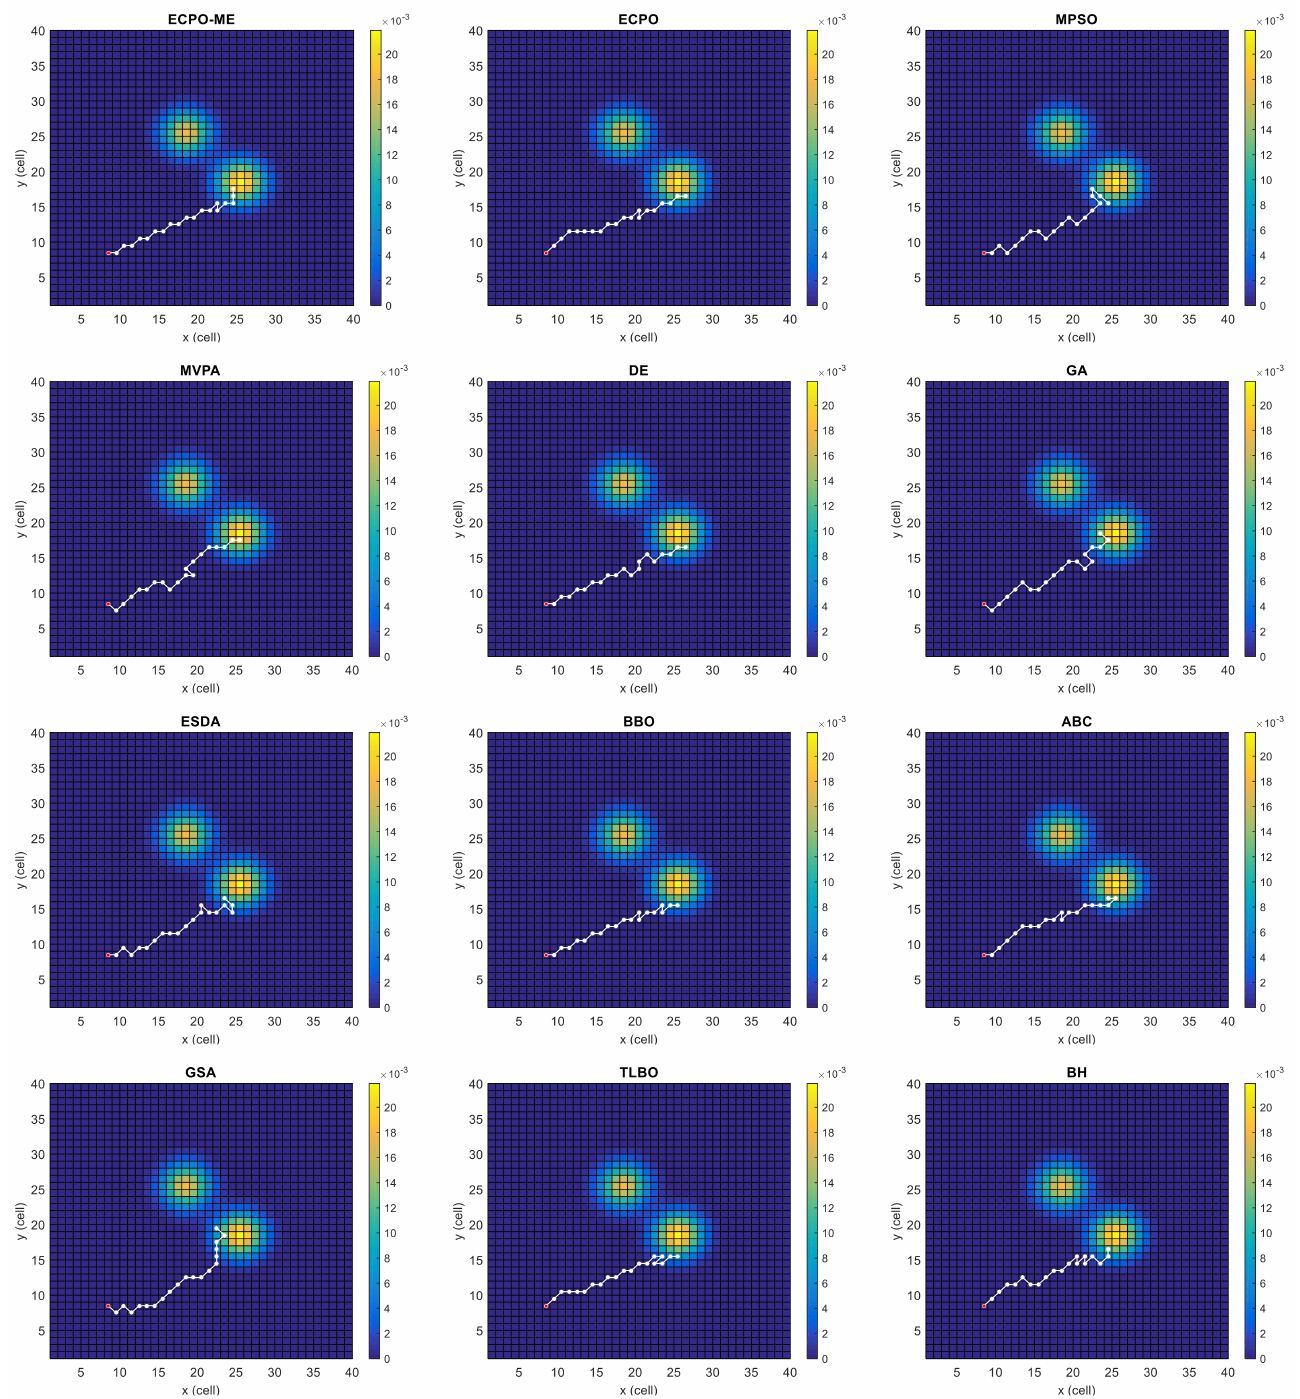
Figure 9. Search paths for Scenario F, obtained using the tested